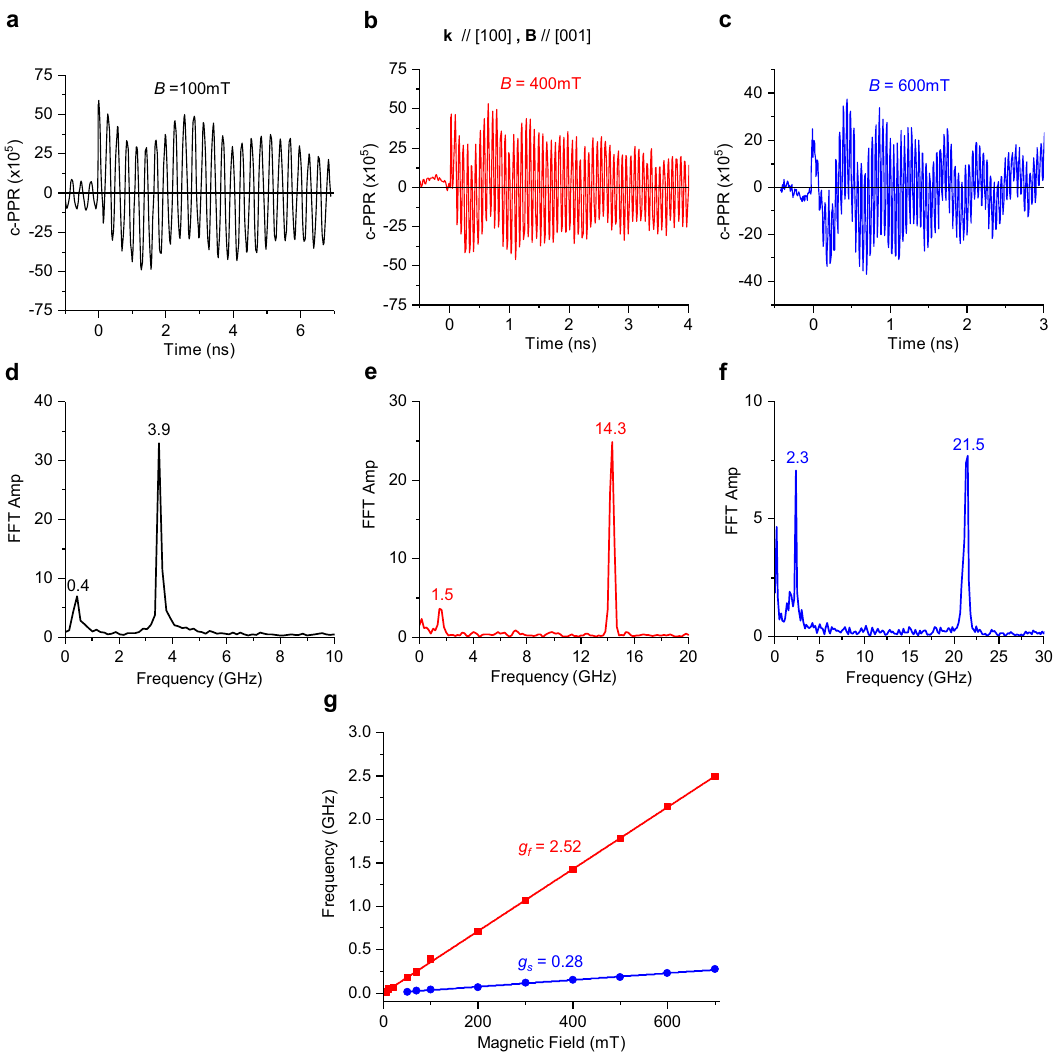
Fig. 2 Photoinduced quantum beatings in MAPbI 3 single crystal at various magnetic fi eld strengths measured at 4 K with light incident along [100] and applied magnetic fi eld along [001]. a – c Magnetic- fi eld dependence of the c-PPR(t) response measured at 758.5 nm pump/probe beams at various fi eld strengths as denoted, and their corresponding FFT spectra d – f . g The corresponding QB frequencies for the fast (red) and slow (blue) beatings vs. B up to 700 mT and the obtained g-values from the various slopes, as